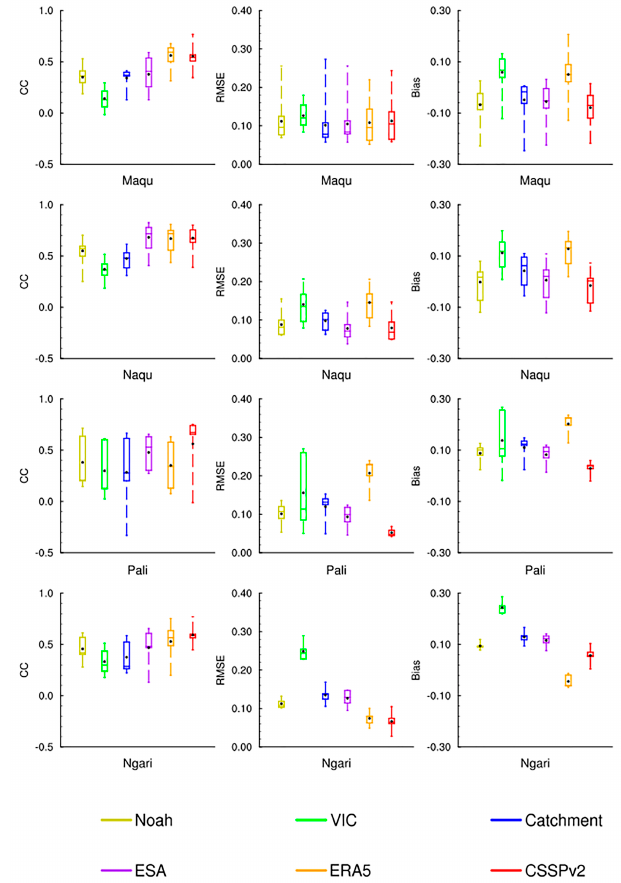
Figure 3. Correlation coefficient (CC), root mean square error (RMSE), and bias of different models and satellite data evaluated at four sub-regional stations. The box graph shows the 95% quantile, 75% quantile, median, 25% quantile, and 5% quantile from top to bottom. The black dot is the average